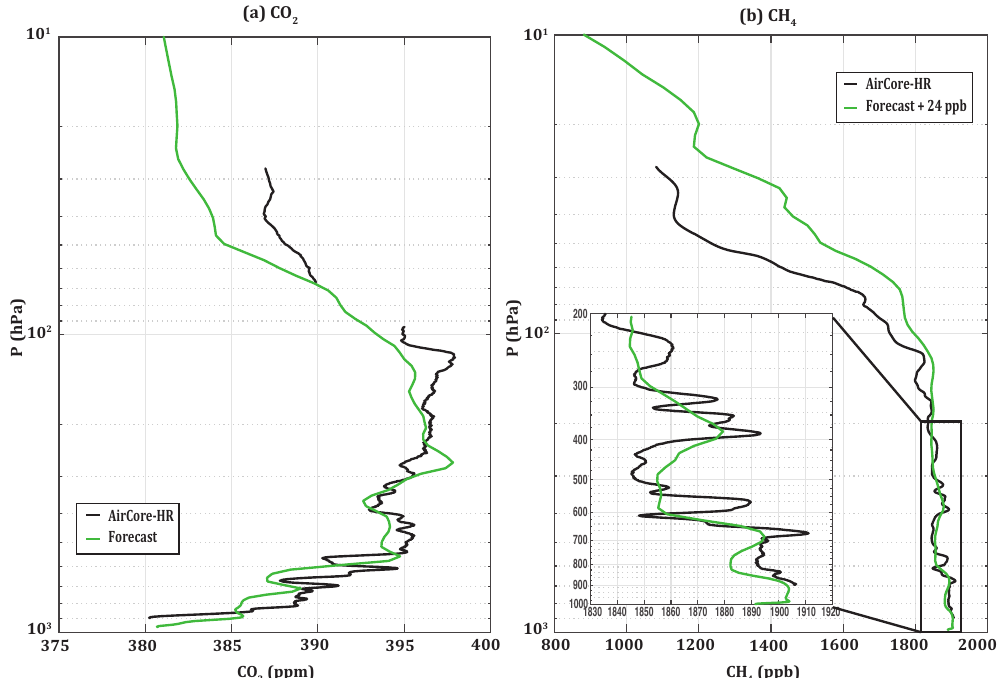
Figure 9. Comparison of AirCore-HR (a) CO 2 and (b) CH 4 vertical profiles (black) with co-located high-resolution forecast (green) from CAMS-ECMWF at landing coordinates on 29 August 2014 at 12:00UTC; 24ppb were added to the CH 4 high-resolution